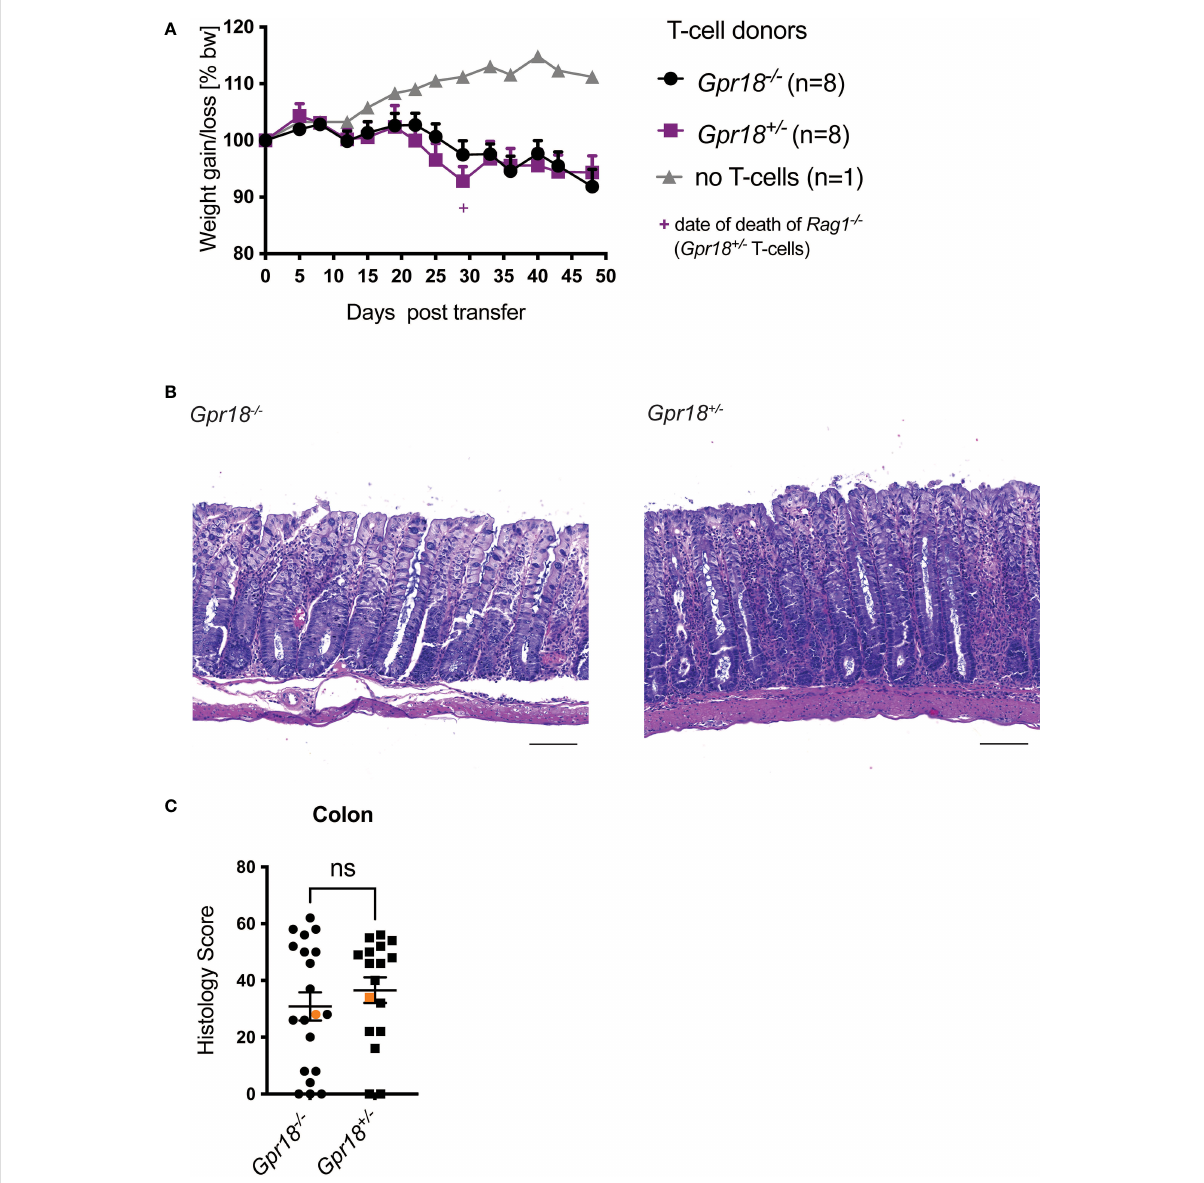
FIGURE 4 GPR18 expression by T cells is not required for colitis in the transfer model. Colitis was induced by adoptive transfer of GPR18 de fi cient ( Gpr18 -/- ) vs. littermate control ( Gpr18 +/- ) naive CD4 + T cells into Rag1 -/- recipients. (A) Weight change was monitored as % starting body weight on the indicated days. A representative weight graph from one of 3 independent experiments is shown. The weight of dead mice was carried forward, indicated with a + sign in magenta for one mouse for Gpr18 +/- T cells. (B) H&E staining of representative colon sections (middle part of whole colon) at 40x (scale bar 100 m m) magni fi cation. (C) Blinded histology scores from the middle part of the whole colon of 3 independent experiments combined. Representative images were taken from mice represented by the orange colored data points. Error bars represent S.E.M. Two-way ANOVA (Tukey ’ s test) (A) and nonparametric T-test (Mann-Whitney test) (C) . ns, not signi fi